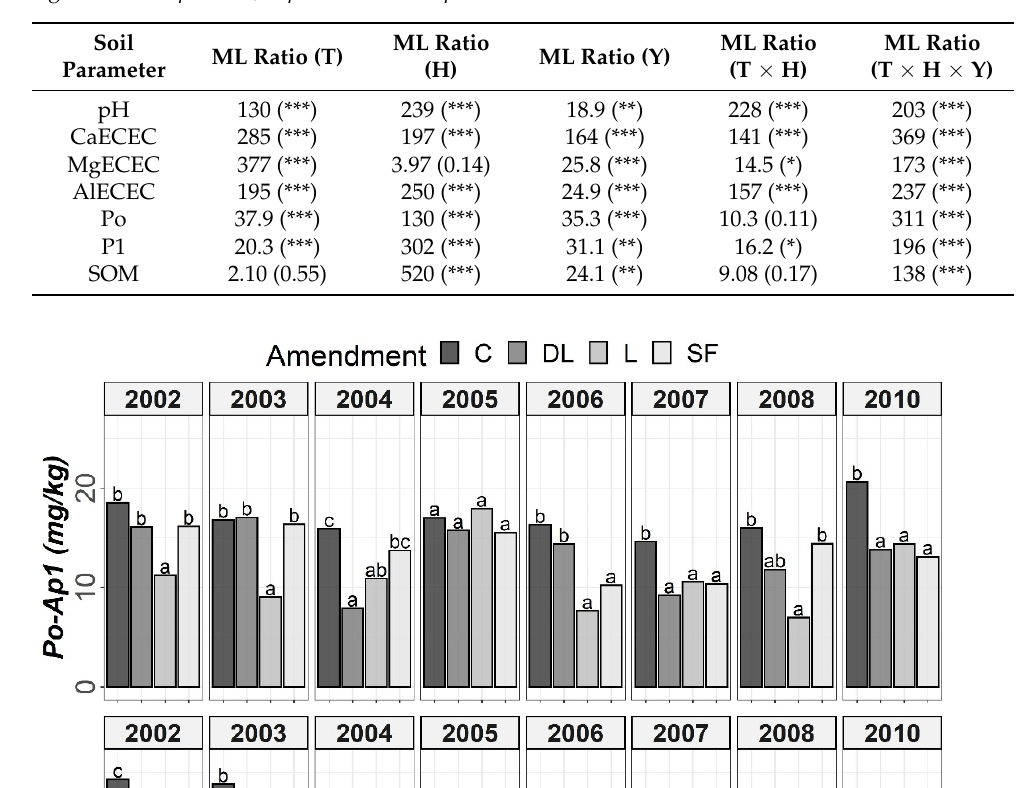
Table 2. Analysis of variance performed on the soil parameters (pH, CaECEC, MgECEC, AlECEC, Po, P1 and SOM). The variability in the soil parameters was evaluated using the hierarchical multilevel model (maximum-likelihood (ML) ratio). T: liming treatment; H: horizon; Y: year. The results were